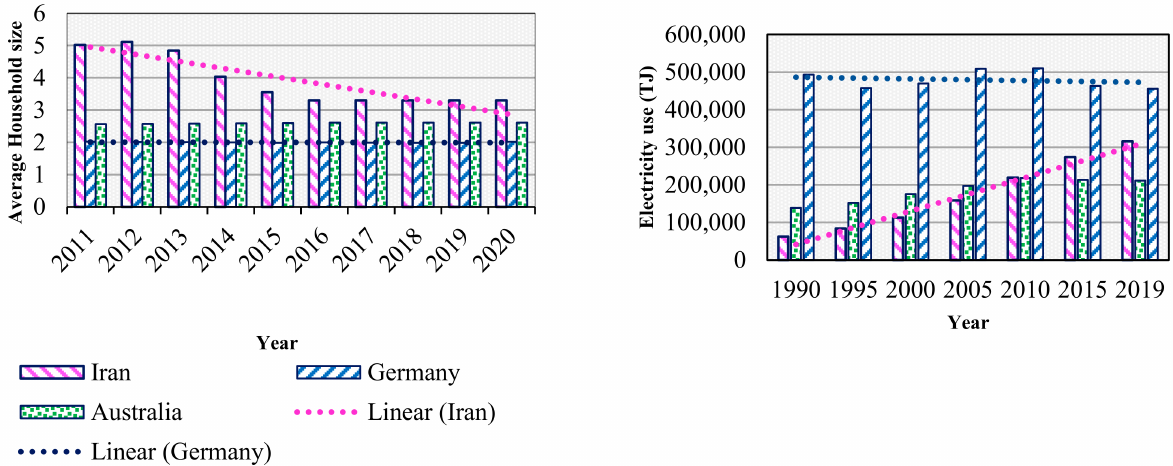
Figure 20. Average household size vs. domestic electricity uses in Iran, Germany, and